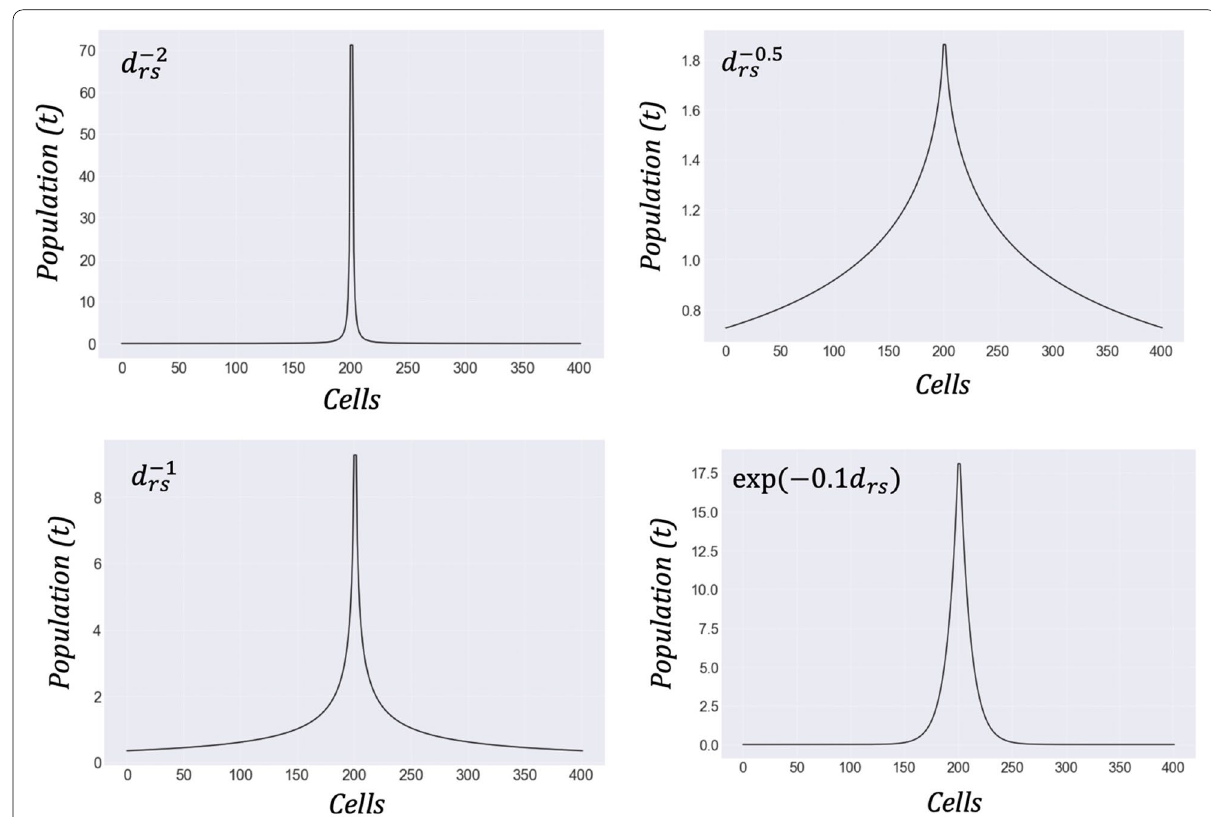
Fig. 5 Agglomeration to a More City-Like Form. The graphs are profiles across the 401 cells on the horizontal axis where the seed site is the central site. The vertical axis is population scaled to sum to the total population which for each example is 401